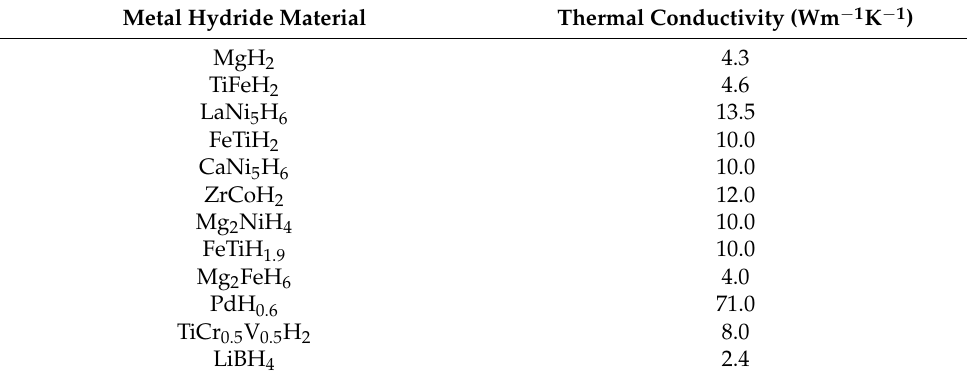
Table 3. Metal hydride materials and their thermal